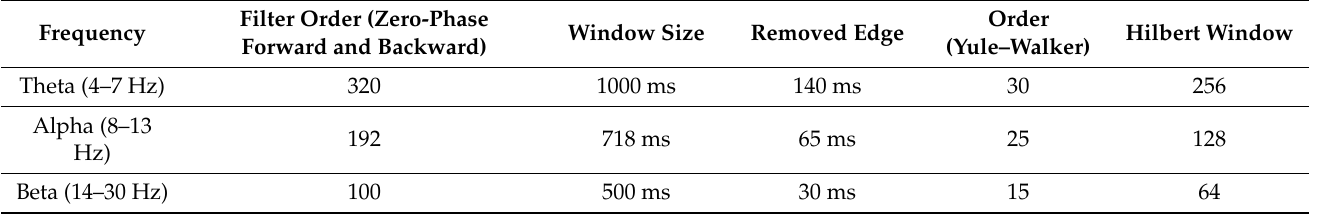
Table 1. The parameters for PHASTIMATE toolbox used in this study for theta, alpha, and beta